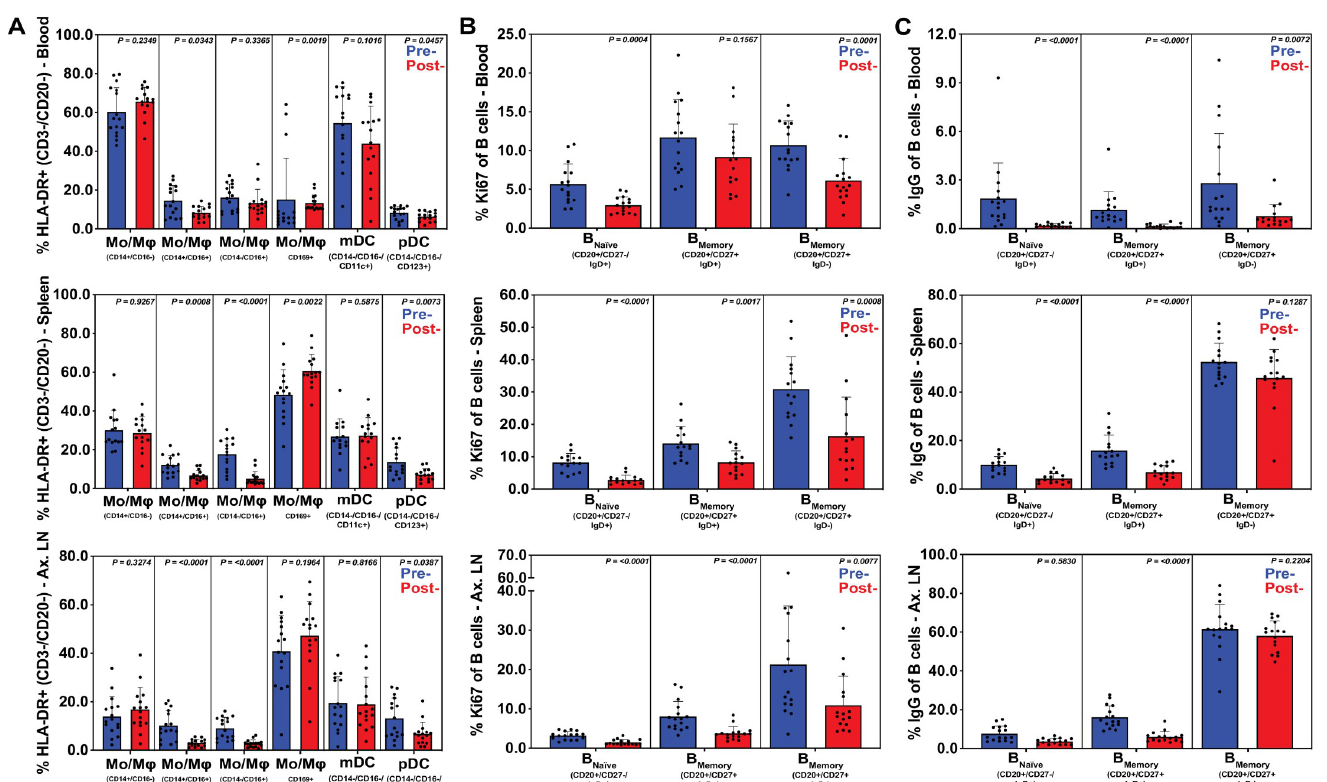
Fig 9. Elimination of EPs following short course multimodal therapy normalized systemic inflammation and immune activation in innate myeloid and B cells. Flow cytometric analysis was performed on B cells, DCs, and MOs derived from whole blood, spleen and axillary lymphoid (ALN), before and after multimodal treatment. Subsets were summed for overall responses with the figure showing the mean (+ SEM) of these overall responses both pre- and post-treatment. Reduced SEM was observed in most tissues with significant decreases in total CD16+ populations in spleen and ALN ( A ) along with significant reductions of pDCs in those tissues. Increased splenic CD169+ on myeloid cells was also observed ( A, panel 4 ). A reduction in B cell expressions of the proliferation marker Ki67 ( B ) and IgG ( C ) in all memory subsets was observed in whole blood, spleen and ALN, showing reduced immune activity in those tissues after therapeutic treatment. Immune cell subsets were defined as described in Figs 5 and